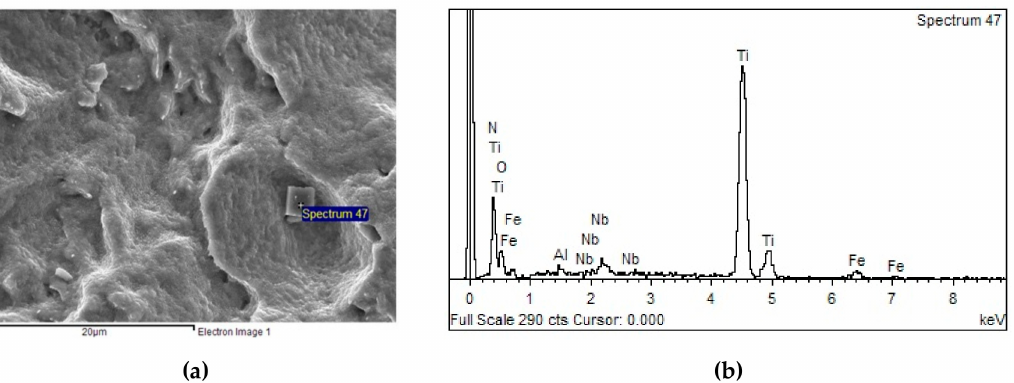
Figure 4. ( a ) Particles on the fracture, sample X4, T Q = 1132 ◦ C, N f = 33.7; ( b ) EDX spectrum from the particle in Figure 4a.